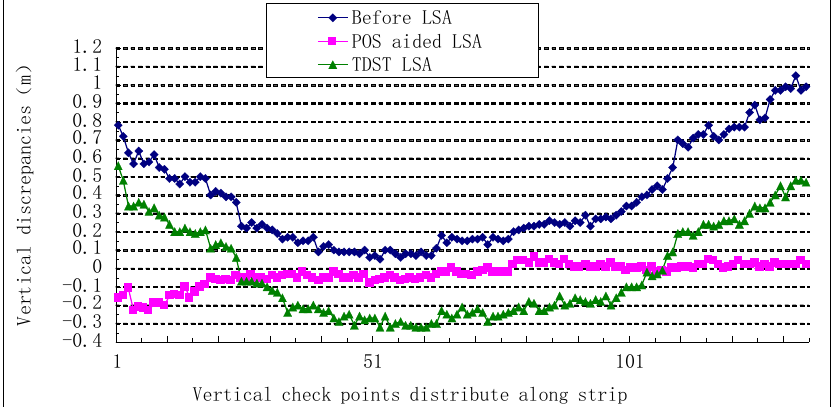
Figure 4. Discrepancies between Las2 and Las3 before and after LSA